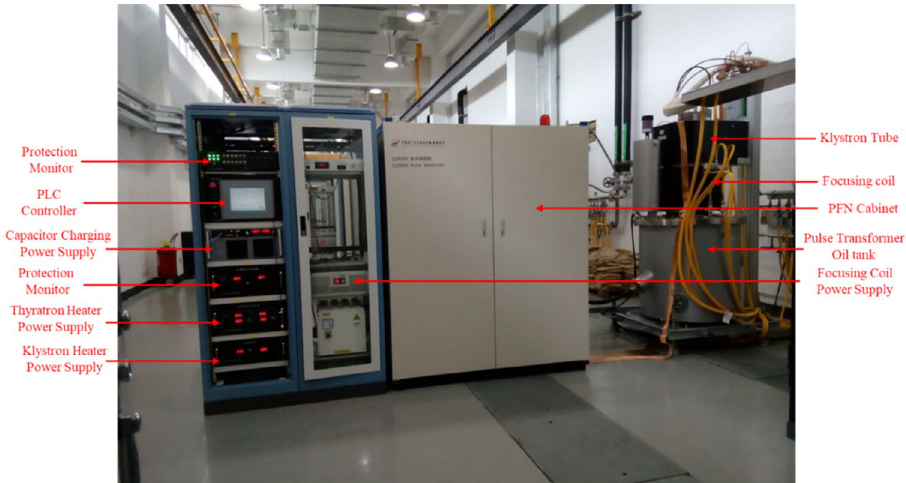
Fig. 2 The picture of C-band klystron and pulse